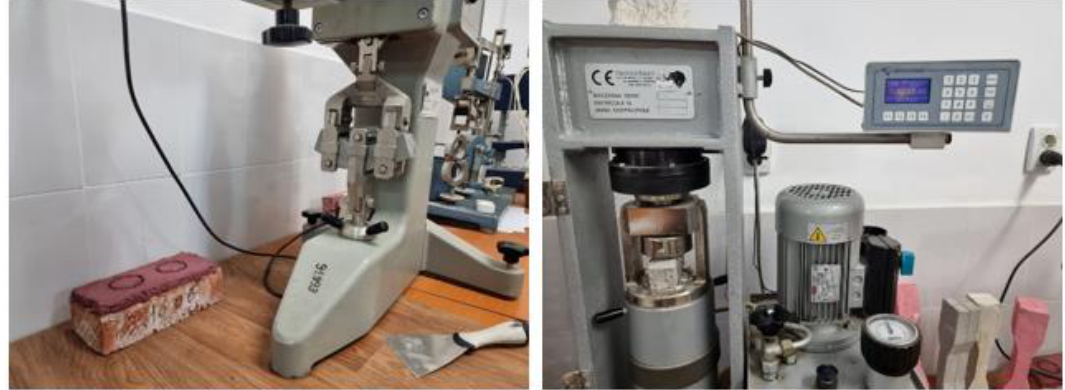
Figure 8. Determination of bending ( left ) and compressive ( right ) strength.